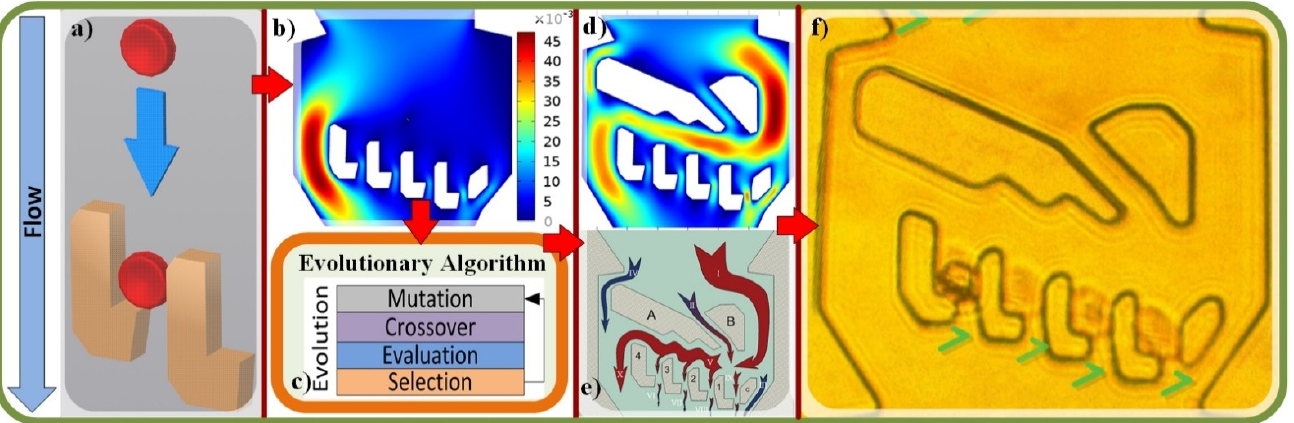
Figure 1. The overall device design sequence. Blue arrow indicates the flow direction; ( a ) the single RBC trapping principle; ( b ) an example of the chamber with trapping structure deign with zero trapping chance due to the low through-trap flow rate; color bar corresponds to the flow velocity distribution ( c ) the evolutionary algorithm which generated necessary flow obstacles to obtain high RBC trapping chances; ( d ) COMSOL simulation of the velocity gradient in the final geometry of the trapping chamber (inflow velocity = 0.01 m/s, no slip boundary condition); ( e ) flow schematics in the trapping chamber; ( f ) experimental results of the prototype system following the evolutionary algorithm design to trap RBCs; green “V”s mark the successfully trapped cells in each slot. Frog RBCs were chosen as the trapping object based on their good availability and bigger nucleated RBCs were chosen for good trapping visualizations. To implicitly account for the number of cells trapped, three physical parameters were calculated for each